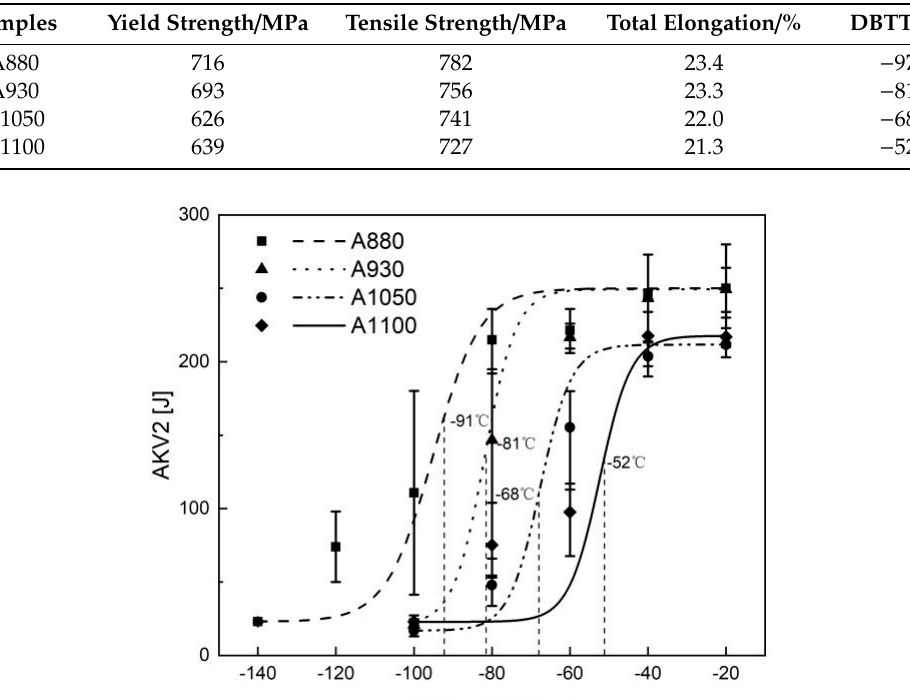
Figure 5. SEM micrographs of samples with different austenitizing temperatures: ( a ) A880; ( b ) A930; ( c ) A1050; and ( d ) A1100.